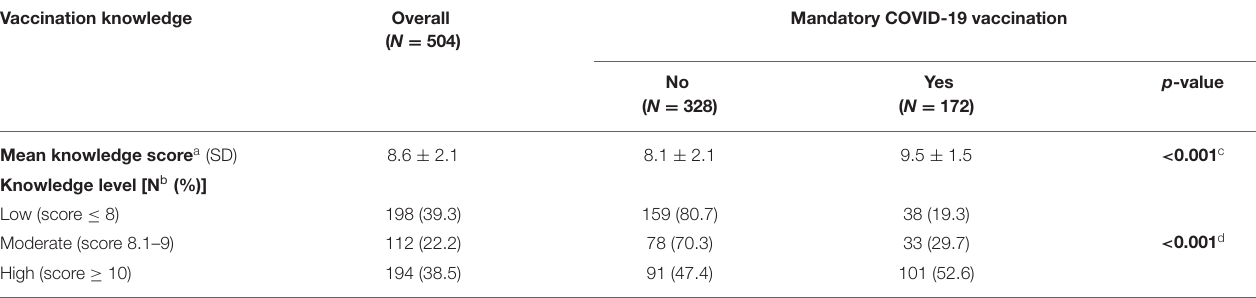
TABLE 3 | Participants’ general vaccination knowledge, overall and by mandatory vaccination support.